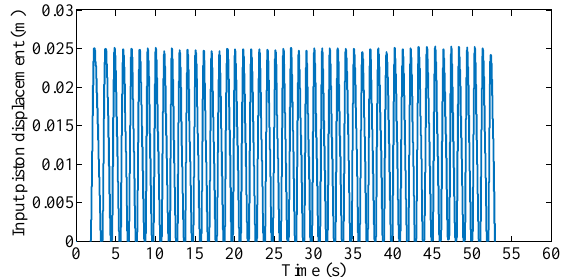
Figure 7. Piston pump input trajectory. Note that there are 50 pumping cycles in total.